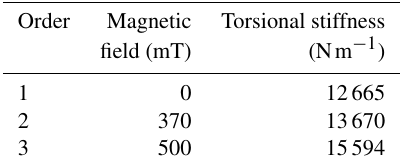
Table 3. Equivalent torsional stiffness with different external mag- netic